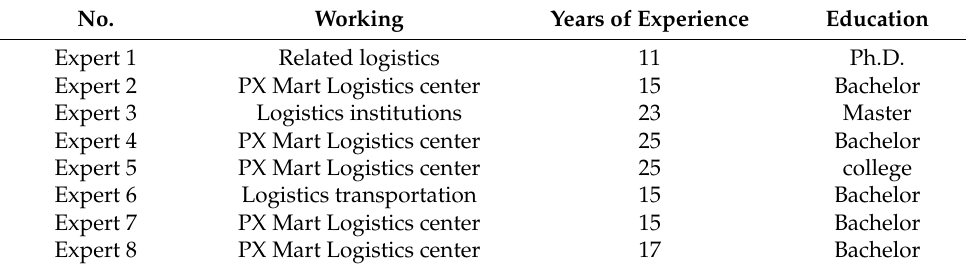
Table A1. Work and educational backgrounds of eight experts.